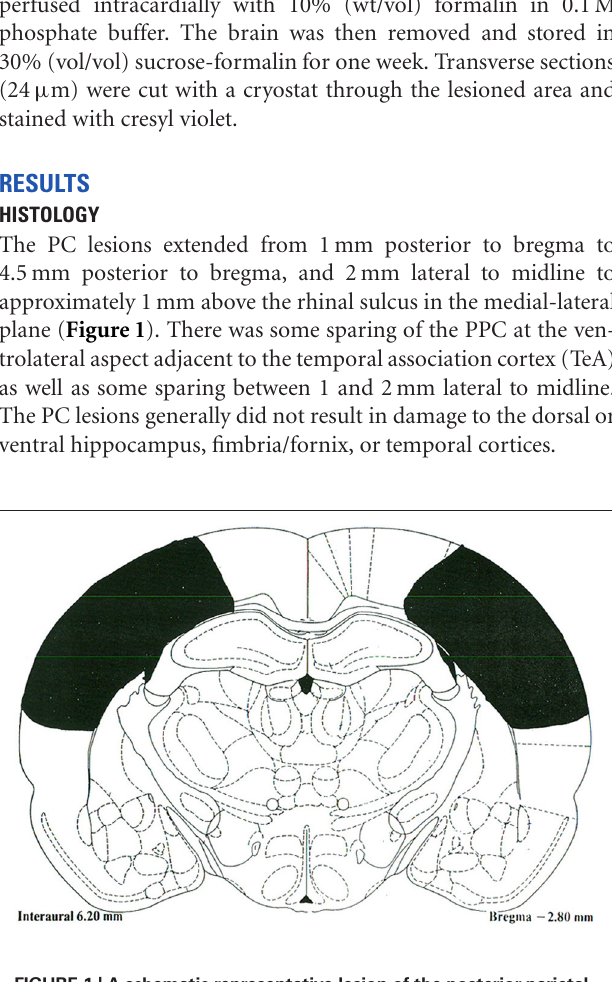
FIGURE 1 | A schematic representative lesion of the posterior parietal cortex projected unto a stereotaxic map of the rat brain [Paxinos and Watson (1997)]. The Rat Brain: In Stereotaxic Coordinates . San Diego, CA: Academic